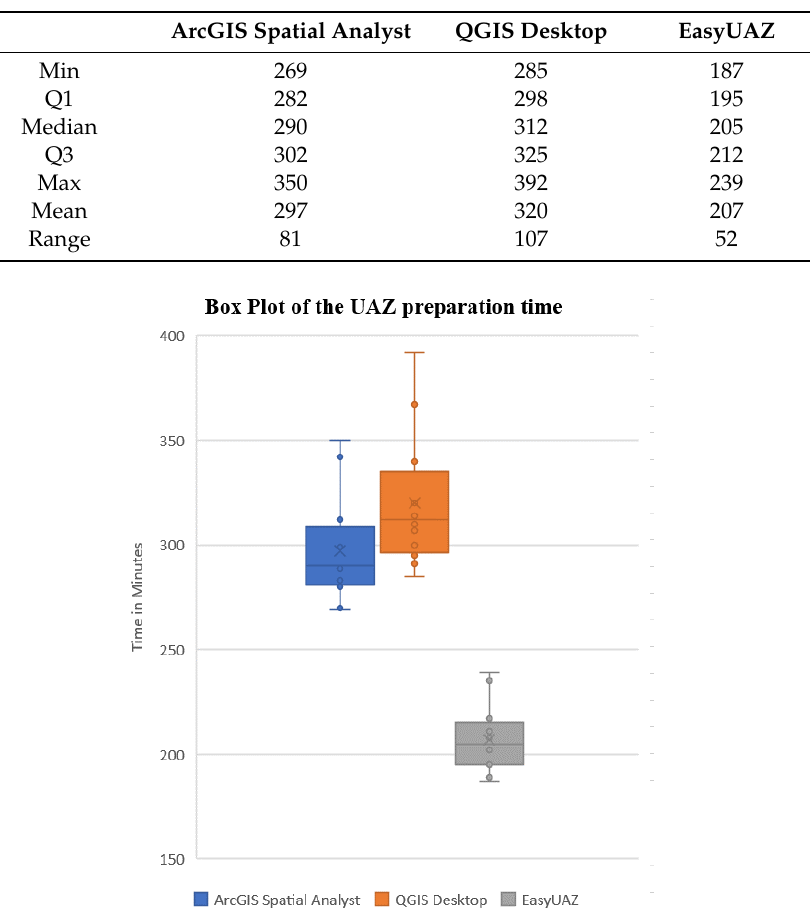
Figure 10. Distribution of UAZ preparation task completion under different workflows. Table 4. The statistical distribution of task completion time (in minutes).